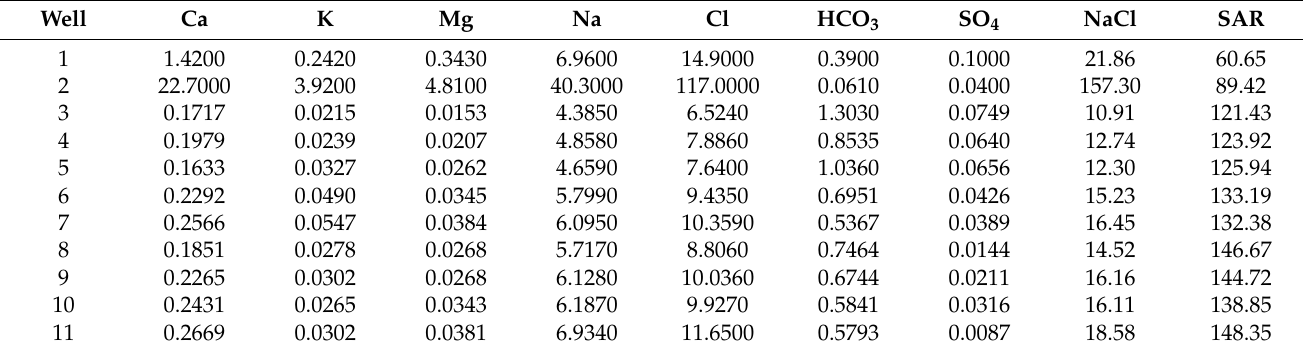
Table 2. Example flowback water compositions from shale gas wells in Australia (Northern Terri- tory (Wells 1 and 2)) and USA (Marcellus Shale (Wells 3 to 11). All measurements are in g L − 1 .